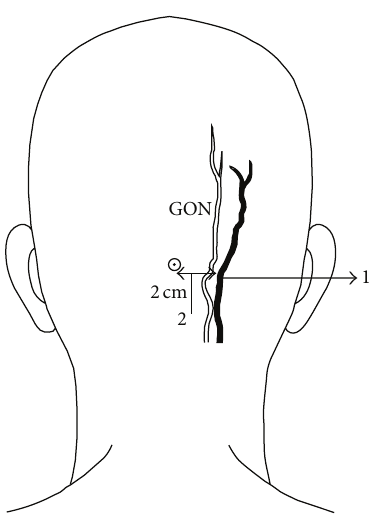
Figure 1: BSCP block is performed by tridirectional infiltration of 0.25% Bupivacaine. The point of insertion is the midpoint of the posterior border of the sternocleidomastoid (SCM). 2 mL each of Bupivacaine is infiltrated cranially (1) and caudally (3) and 1mL horizontally over the muscle (2).